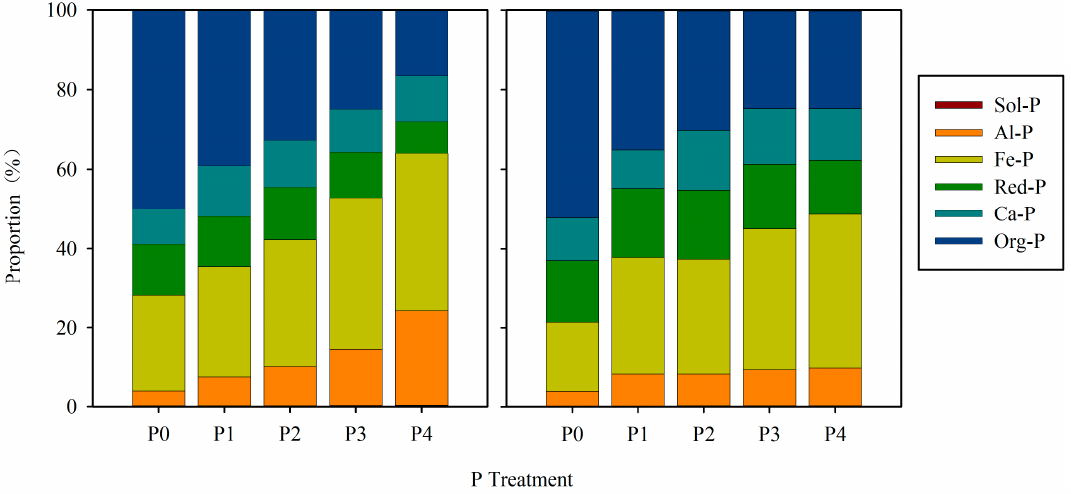
Figure 4. Proportions of various fractions of P in different treatments come from the field experiment (left: surface soil, right: subsurface soil).